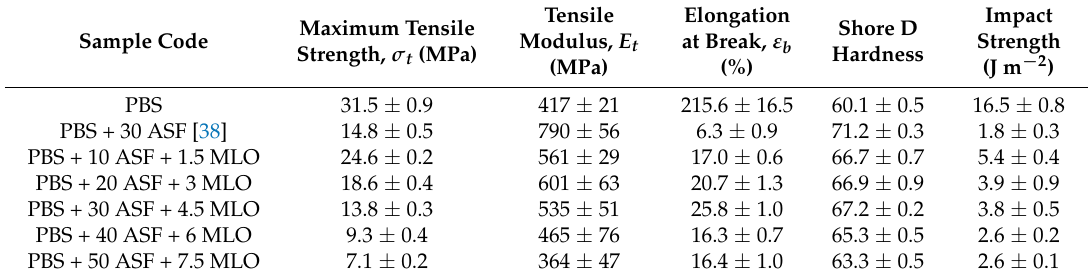
Table 2. Summary of the main mechanical properties of PBS/ASF/MLO composites obtained by tensile, hardness and impact